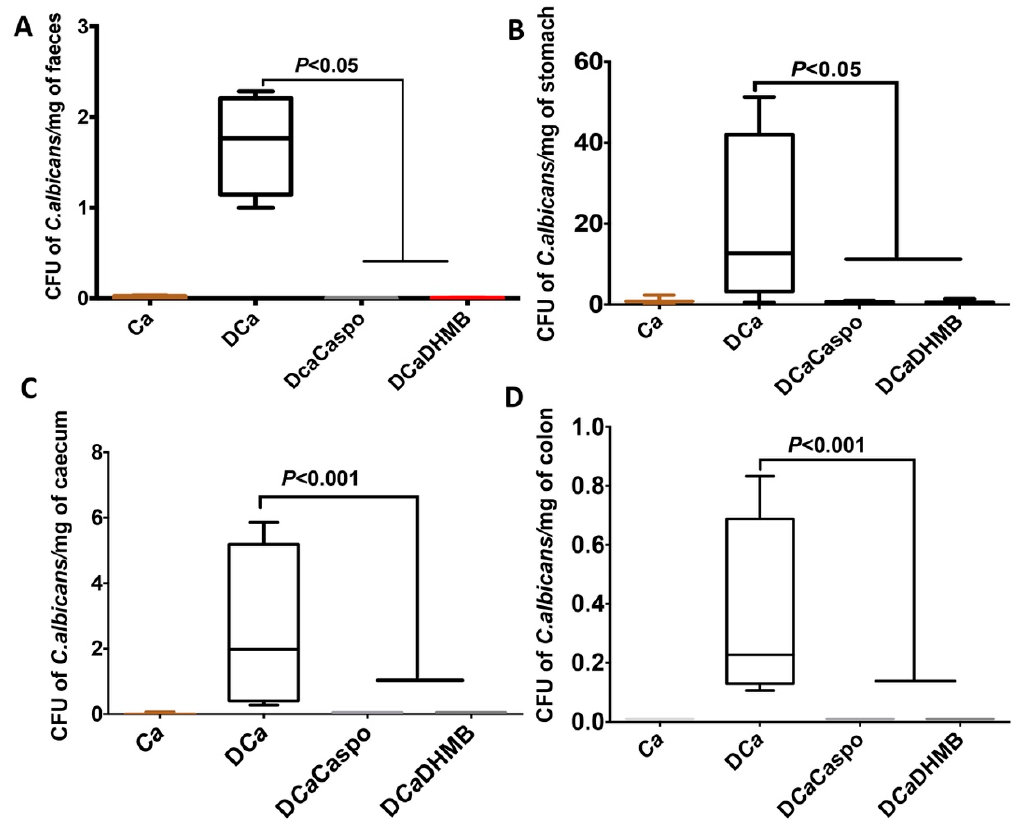
Figure 6. Effect of DHMB on C. albicans elimination from the gut. ( A – D ) Number of C. albicans colonies recovered from the stools, stomach, cecum and colon. Data are the mean ± SD of 10 mice per group from two independent experiments ( p < 0.001).